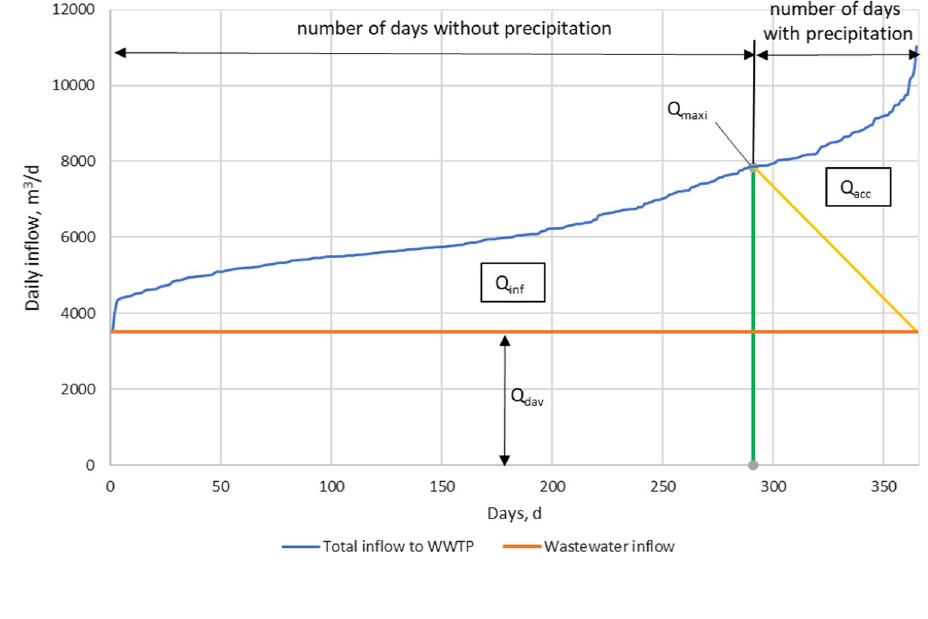
Fig. 7 Volumes of infiltration and accidental water inflow to WWTP in 2019 determined using the triangle method